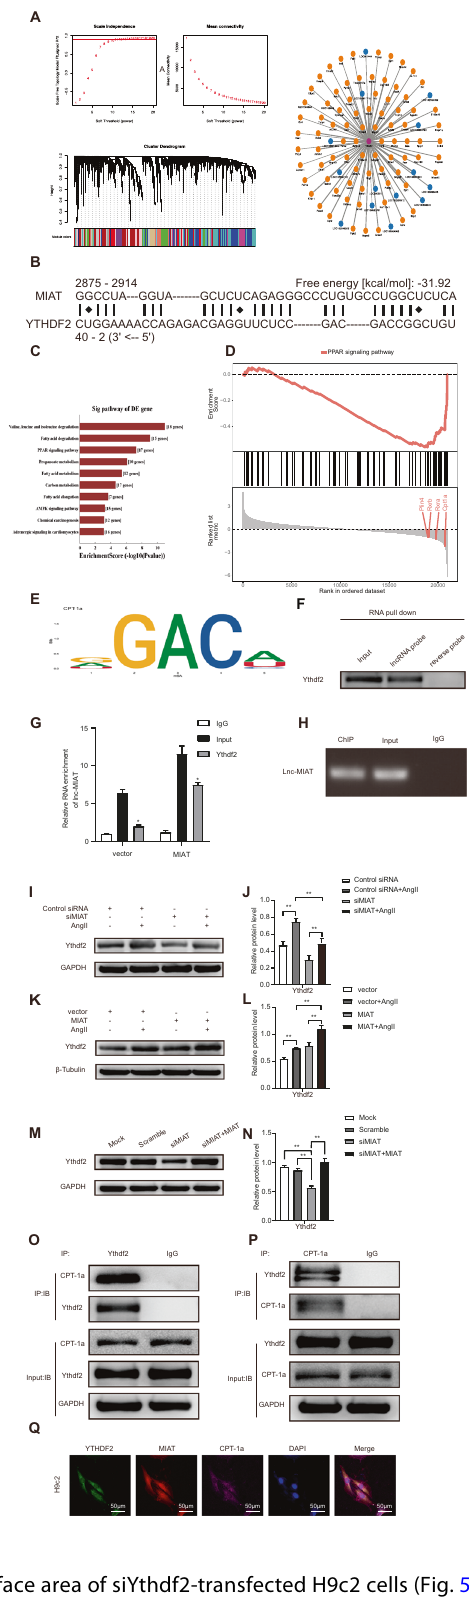
cell surface area of siYthdf2-transfected H9c2 cells (Fig. 5H, I). RT- qPCR con fi rmed that MIAT was the upstream of Ythdf2 (Fig. 5J). As anticipated, Ythdf2 functioned as a downstream of MIAT in cardiac hypertrophy.